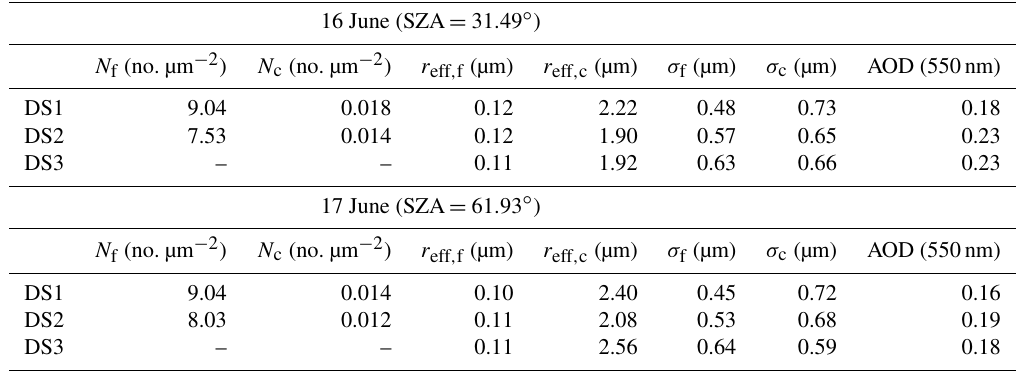
Table 4. Column-integrated number concentration ( N ), effective radii ( r eff ), and standard deviation ( σ ) of fine and coarse aerosol modes and AOD at 550nm for DS1, DS2, and DS3 on 16 and 17 June.